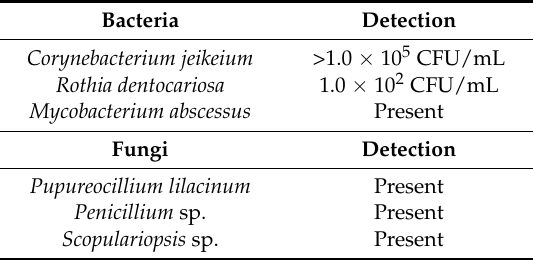
Table 2. Culture and molecular data from the bacteriology laboratory.